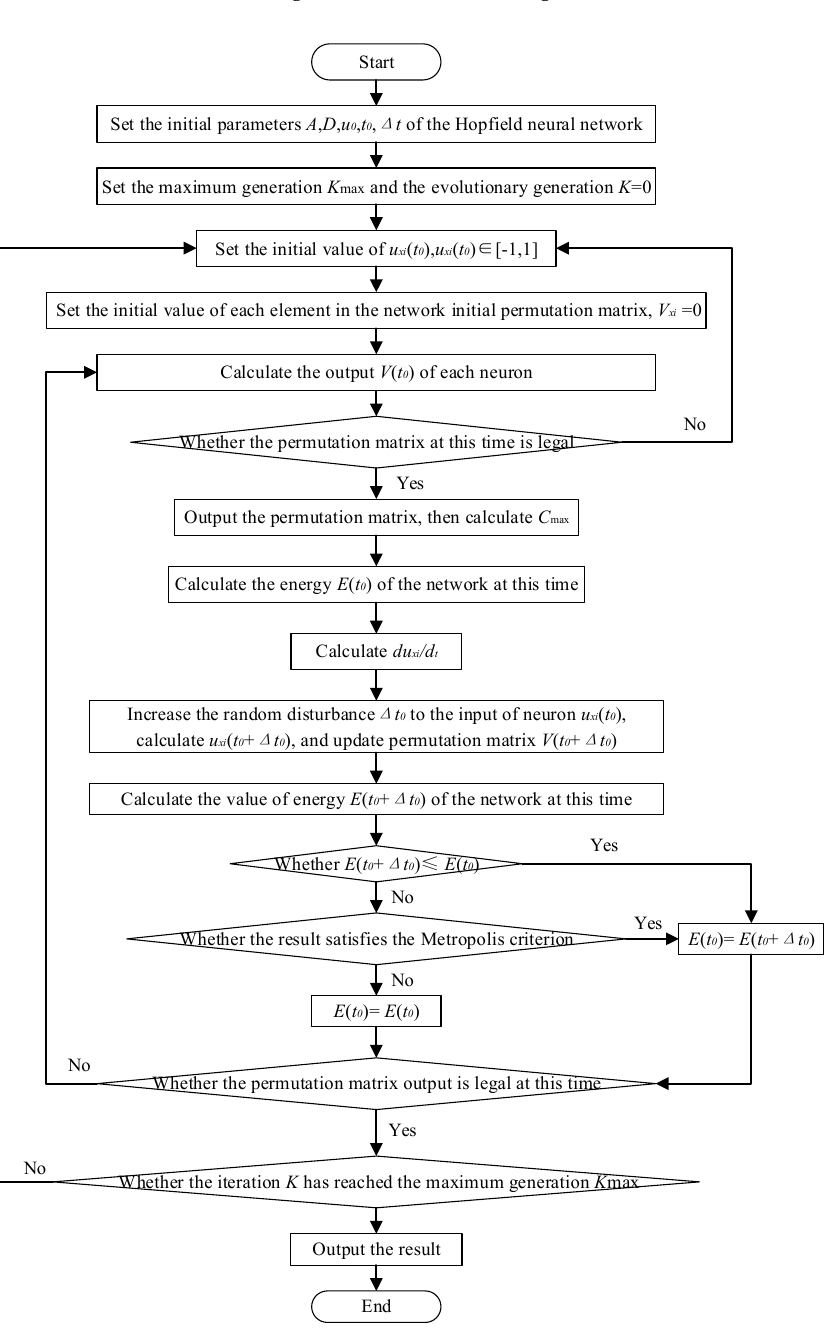
Figure 2. The flowchart of the SAA–HNN algorithm.